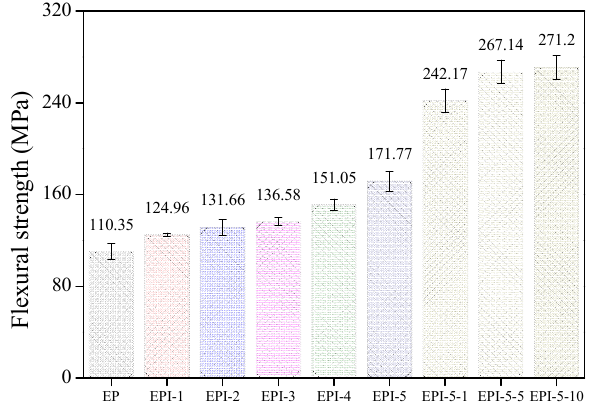
Figure 6. Flexural strengths of cured epoxy/polyimide blend composites.